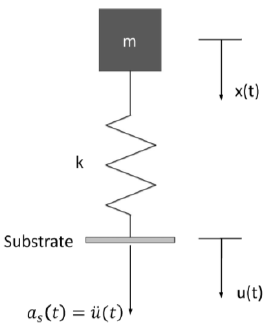
Figure 4. SDOF model of the MEMS suspended inductor.